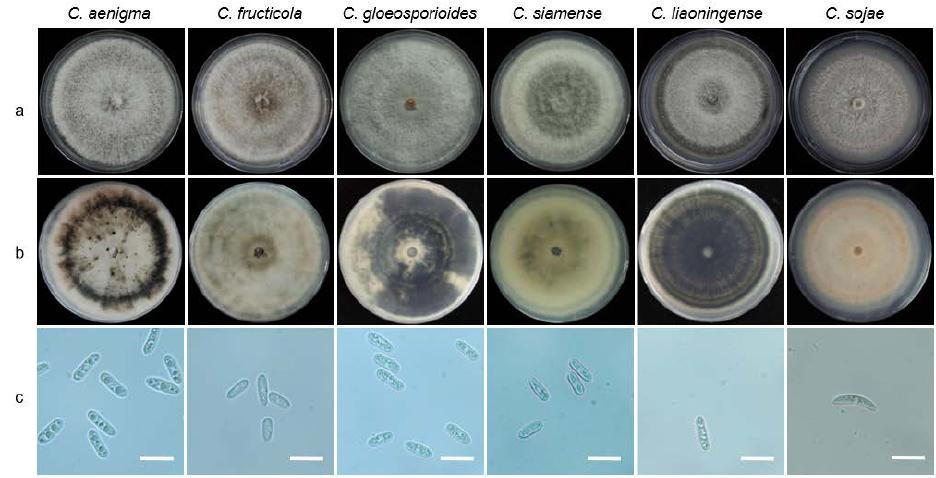
Figure 5. Morphological characteristics of Colletotrichum isolates from walnut anthracnose cultured on PDA for 5 days. ( a ) and ( b ), upper and reverse view of colonies. ( c ), conidia. Scale bar = 20 μm.